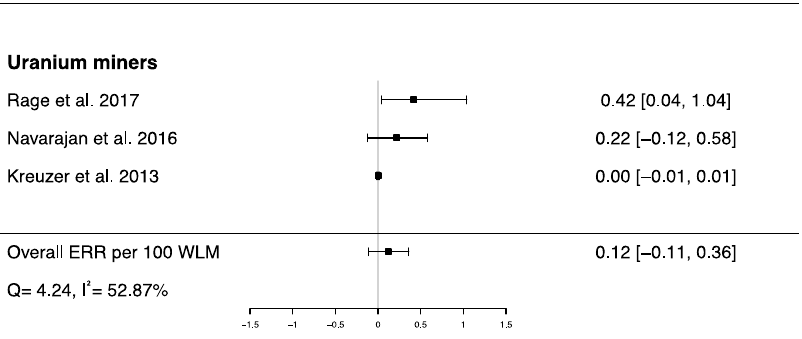
Figure 8. Excess relative risk (ERR) per 100 WLM and 95% confidence interval (CI) for mortality from cerebrovascular diseases in relation to IR exposure.